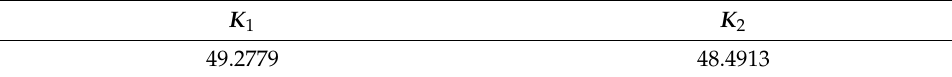
Table 3. DCI controller gains at 70% Table 2. PI controller gains for 70% dip.